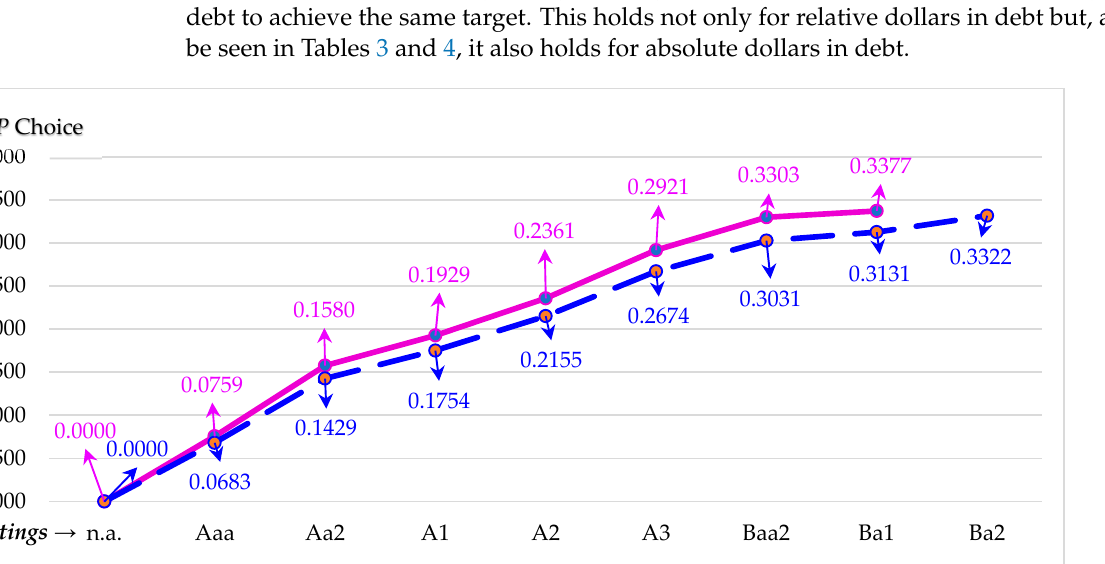
Figure 2. Gain to leverage ( G L ) values are plotted along the vertical axis against Moody’s credit ratings along the horizontal axis. The nonprofit trajectory is the solid line and the pass-through trajectory is the dashed line. We use credit spreads for 2019, TCJA low ( L ) tax rates, and 3.12% growth where the growth ( RE ) constraint sets in after Ba1 for nonprofits (NPs) and after Ba2 for pass-throughs (PTs). The optimal credit rating ( OCR ) is A3.